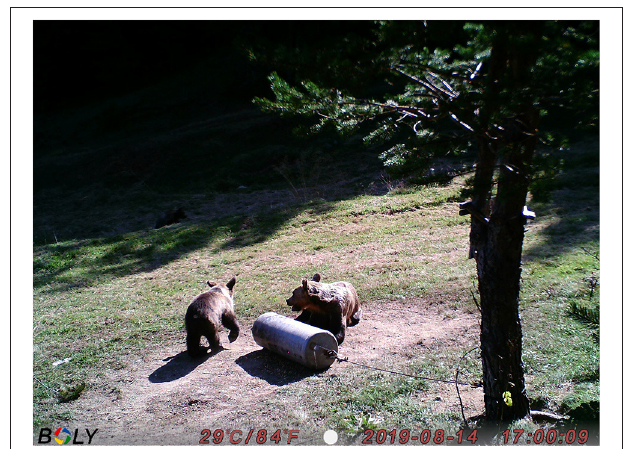
FIGURE 3 | Bears feeding on the corn at the game feeders.